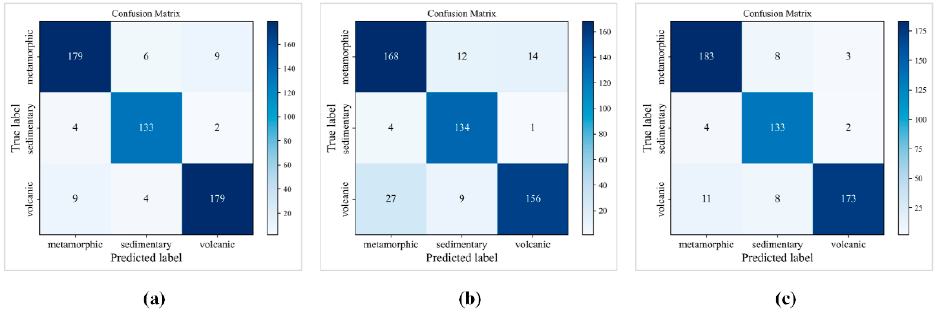
( d ) Figure 19. ( a ) Training loss of MobileNetV2 under three optimizers; ( b ) results of metamorphic rock